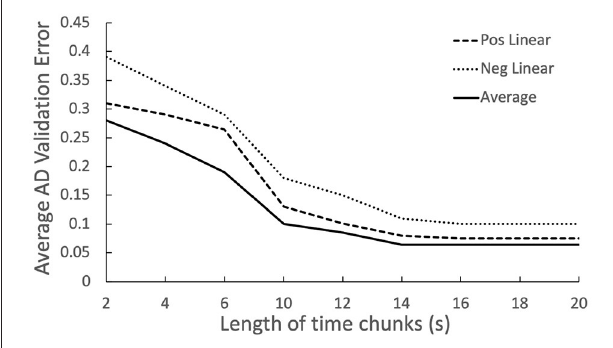
FIGURE 7 | (A) Saliency map to study the explainable AD evolution for all the patients in the study based on the predictions of individual biomarker models. BrainOS (2, 8, 14, 20) show the model prediction at different chunk sizes. This map could be used to longitudinally monitor subjects where a lower score on the biomarkers may indicate a more progressed AD subject. (B) Saliency map comparing AD + subject S092 with a solid line and AD- subject S019 represented with a dashed line.